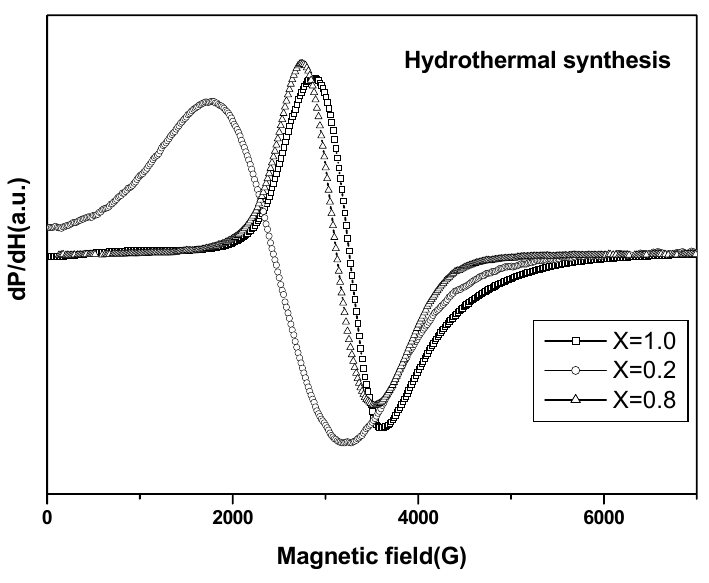
Fig. 5 ESR Spectra of Nanoparticles of Ni x Co 1 − x Fe 2 O 4 for x= 0.2, 0.8,